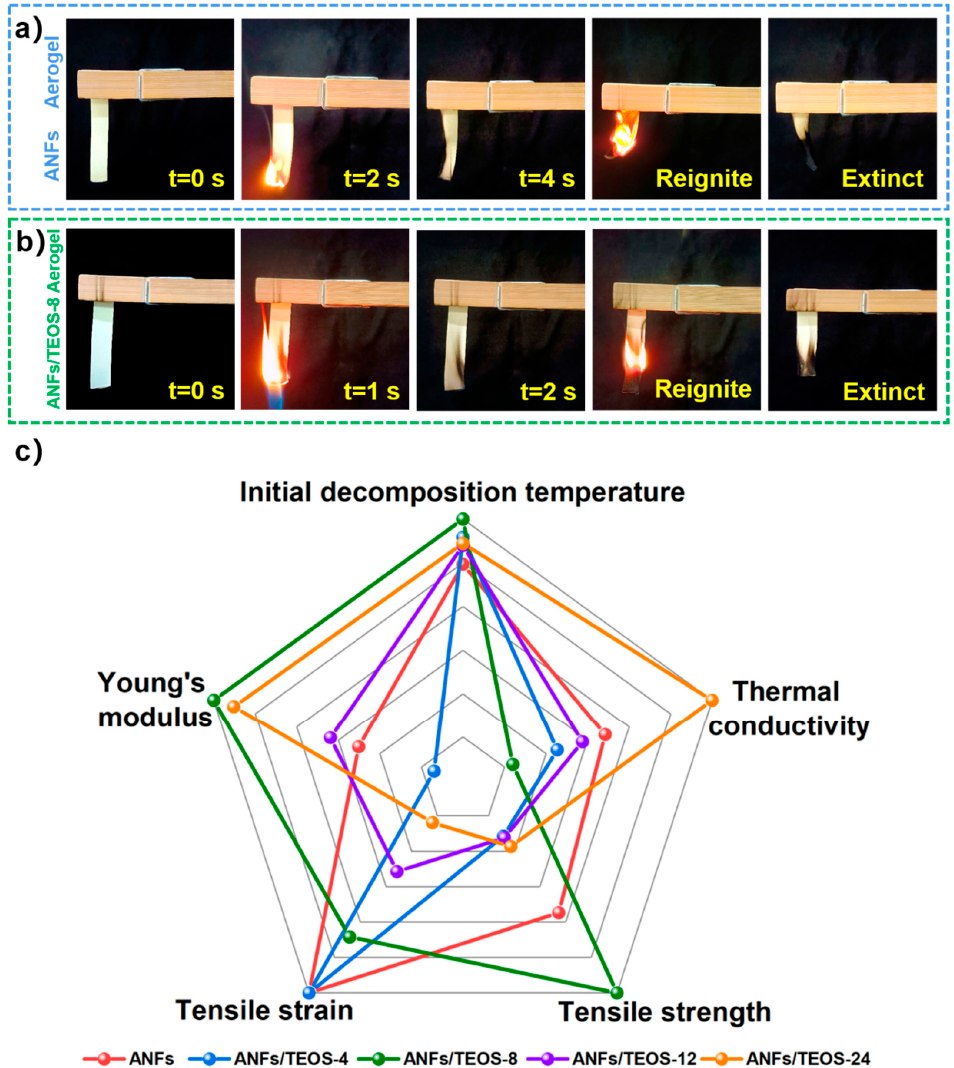
Figure 7. Flame-retardant experiments of ( a ) ANFs and ( b ) ANFs/TEOS-8 aerogel samples. ( c ) Radar map comparing the comprehensive properties of various aerogels.